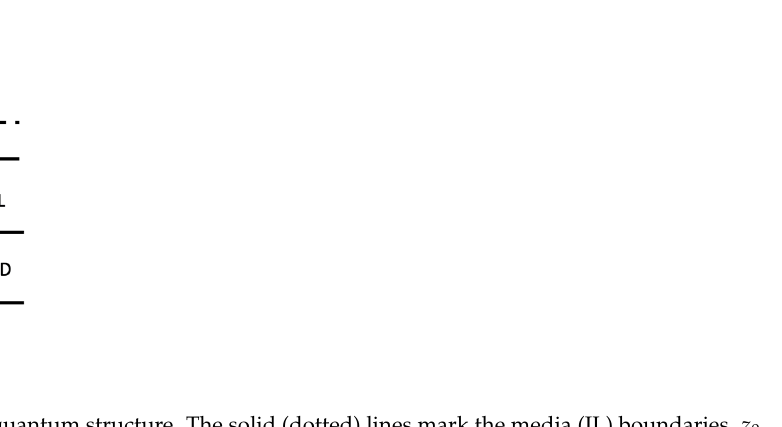
Figure 1. Multi-layer quantum structure. The solid (dotted) lines mark the media (IL) boundaries. z 0 denotes the impurity position in the IL.